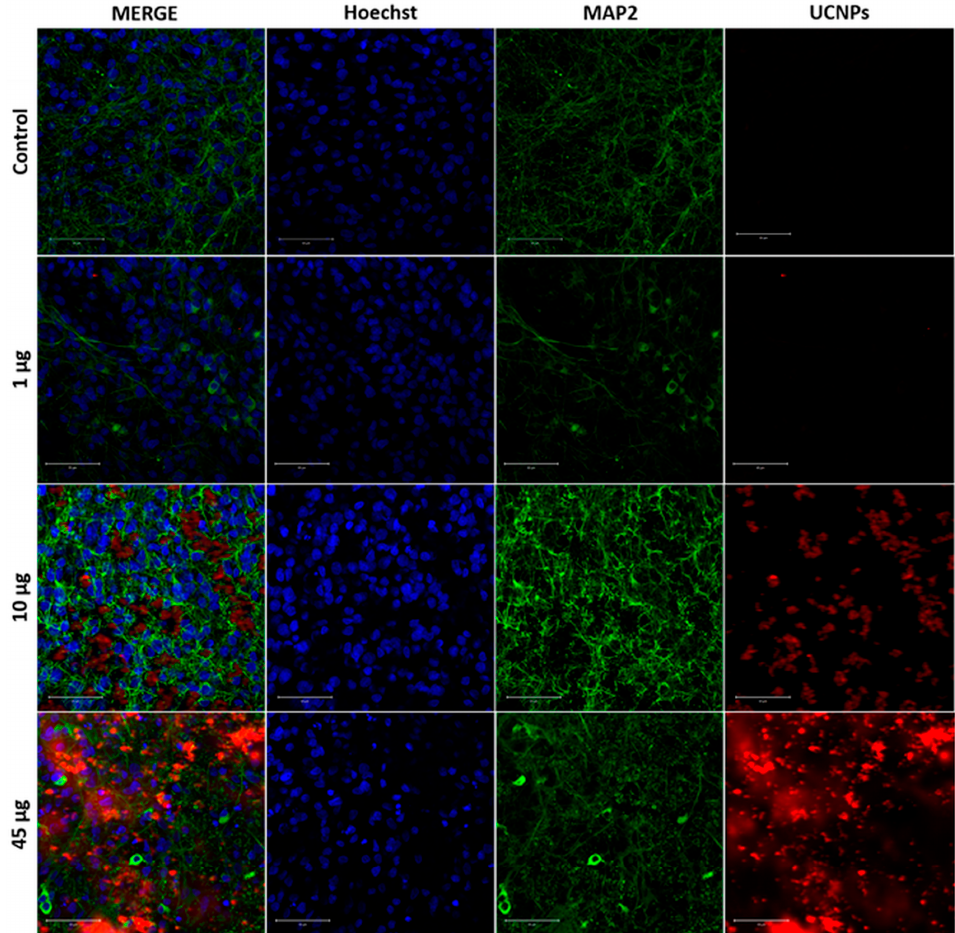
Figure 5. Confocal images of OHSCs after 2 h of incubation with UCNPs depend on the concentration (1, 10, and 45 μ g in 4 μ L of medium) applied in the form of droplets on the surface of the OHSCs. The UCNPs were excited with a 980 nm femtosecond laser (red color), neurons (MAP2) were excited with a 488 nm argon laser (green color), and cell nuclei were stained with Hoechst 33342 dye and excited with a 690 nm femtosecond laser (blue color). The presented MERGE image is a composite of all images. Controls were OHSCs without UCNPs. Scale bar—50 μ m.